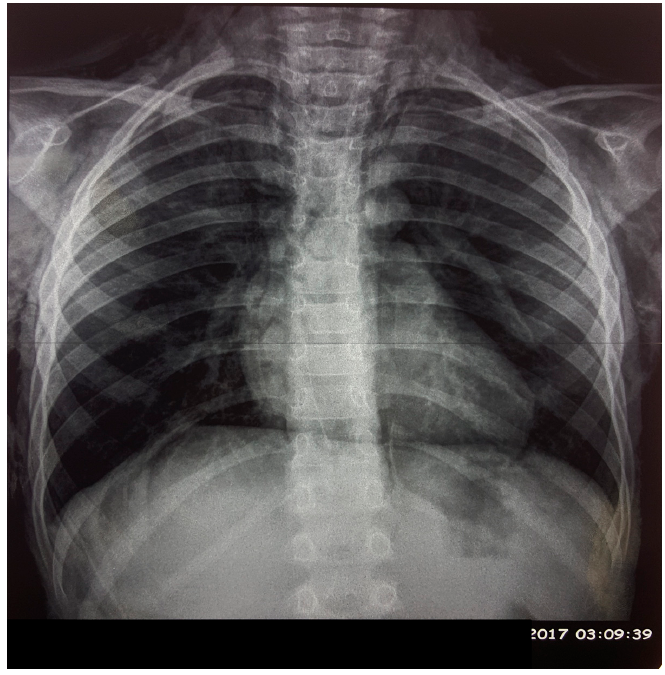
Figure 1. Chest X-ray showing emphysema and pneumomediastinum.